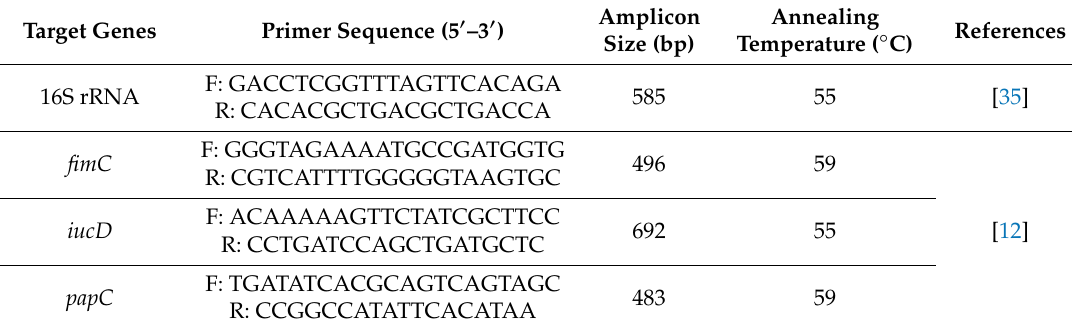
Table 1. Primers used in the detection of avian pathogenic Escherichia coli (APEC)-associated virulence